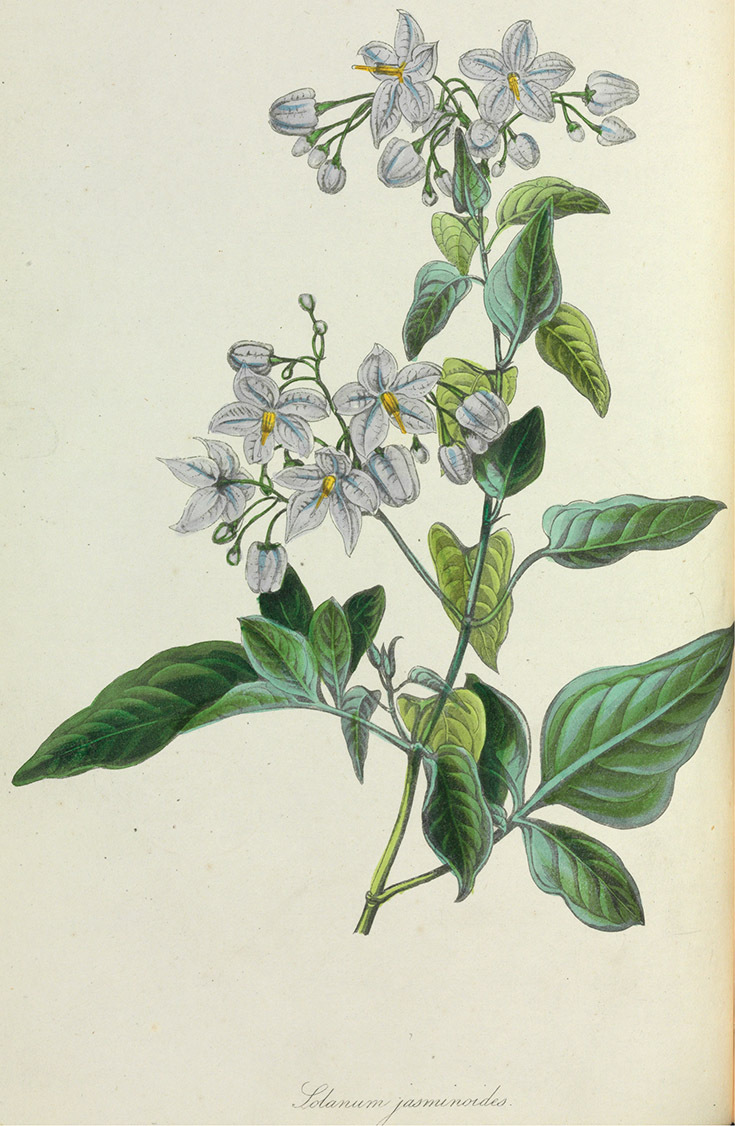
Lectotype of Solanum jasminoides Paxt. (Paxton 1841: tab. 5) Reproduced with permission of the Natural History Museum Botany Library.